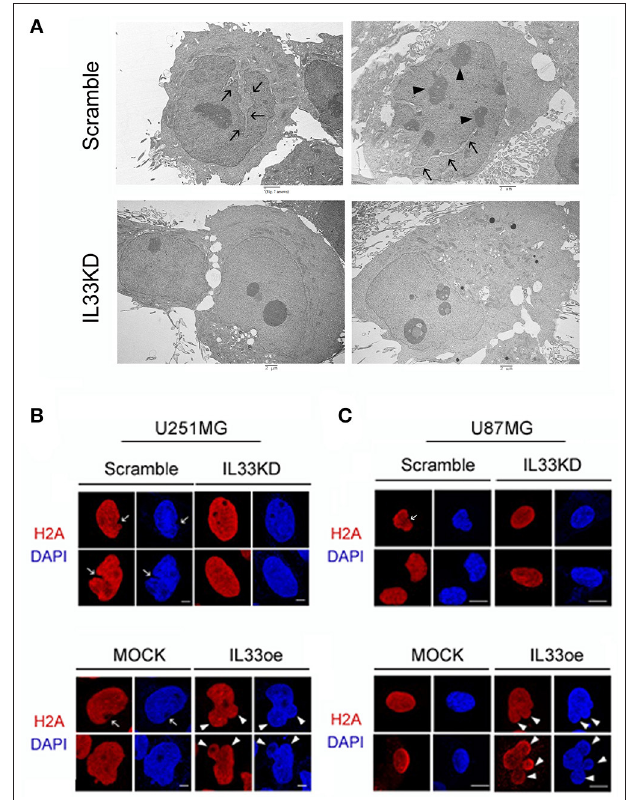
FIGURE 6 | Altered expression of nuclear IL-33 causes a change in the nuclear shape of human glioma cells. (A) Scramble- and IL33KD-U251MG cells were prepared for TEM imaging examination. Representative TEM images show a nucleus with grooves and long clefts (arrows), or with multiple nucleoli (arrowheads). Similar results were observed in the different passage cell cultures. Scale bar, 2 µ m. (B) Representative confocal images of immunofluorescent staining for H2A (red) and DAPI counterstaining (blue) show cancerous nuclear groove and cleft in Scramble- and MOCK-U251MG cultures (arrow), and indicate multiple nuclear lobes in IL33oe-U251MG cultures (arrowheads). (C) Representative confocal images of H2A immunofluorescence H2A (red) and DAPI counterstaining (blue) indicate nuclear cleft in Scramble-U87MG cells (arrow) when compared to those seen in IL33KD-U87MG cells. In addition, polylobulation in IL33oe-U87MG cultures is indicated by arrowheads. The experiments were repeated with